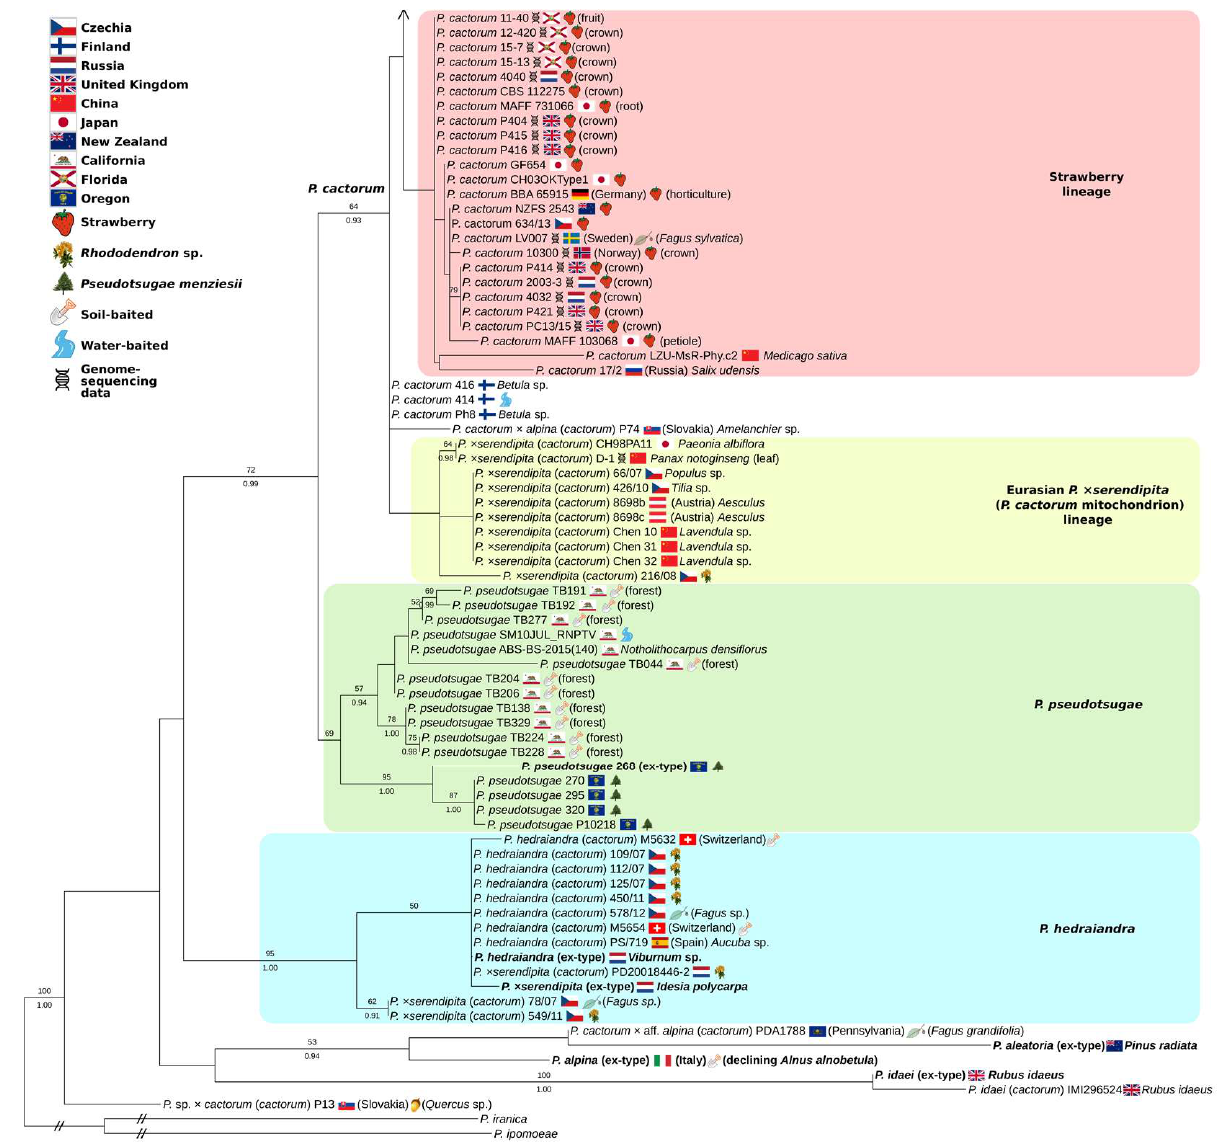
Figure 4. The 169-isolate, multi-locus maximum likelihood tree of Phytophthora subclade 1a (bottom). Tree inferred with IQTREE2 2.1.2 from ITS rDNA, mt cox2+spacer and mt cox1 loci, with a total of 2936 characters. Near-zero branches were collapsed with gotree (github.com/evolbioinfo/gotree, accessed on 31 December 2021). Support values above branches are percentages ≥ 50 from 1000 non-parametric bootstrap replicates, and Bayesian posterior probabilities ≥ 0.90 from a separate analysis in MrBayes 3.2.7. Tree edited in TreeGraph2 and InkScape. Slashes indicate branches that were artificially shortened for display purposes. Sequence accessions are listed in Table S1.